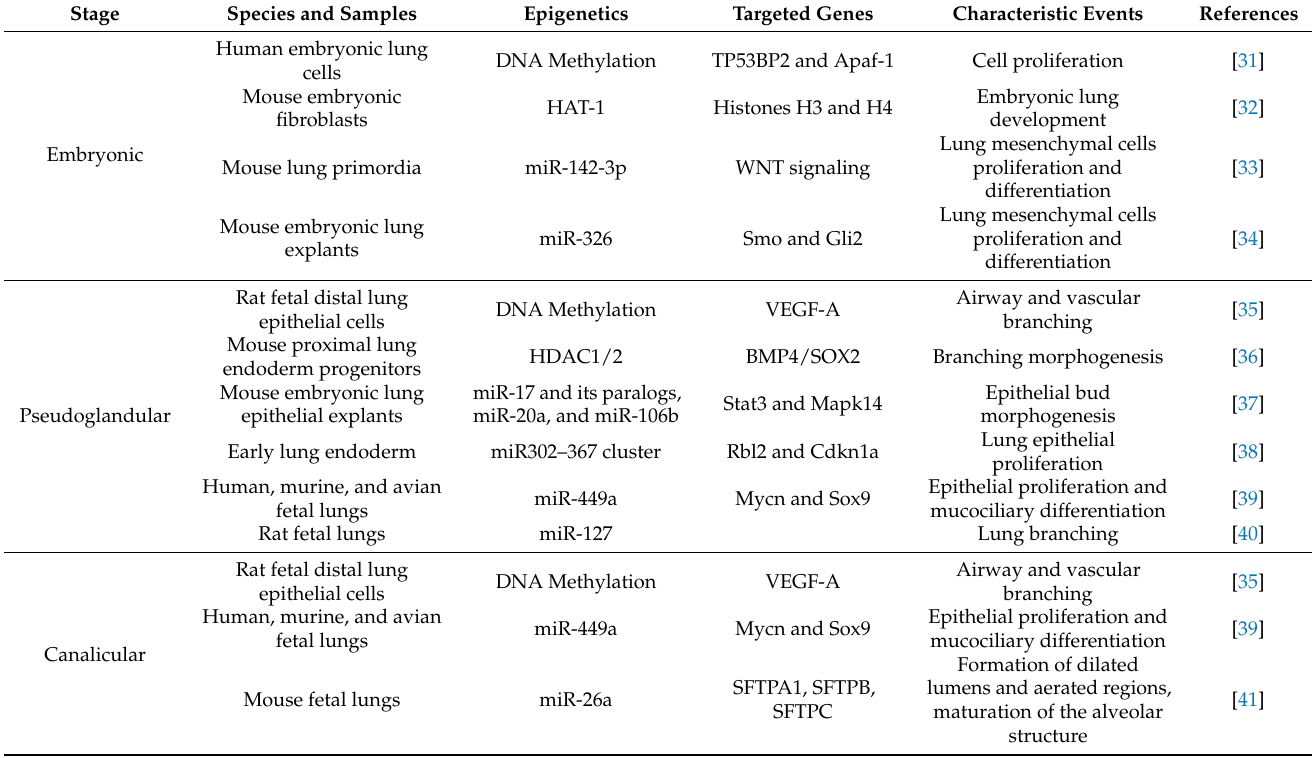
Figure 1. Epigenetic regulation of lung development. Schematic depicting of epigenetic components such as DNA methylation, histone acetylation, and miRNA expression to modify targeted genes and determine phenotypes at different lung development stages. These epigenetic components may have a crosstalk effect. Table 1. Lung development and epigenetic regulatory components.